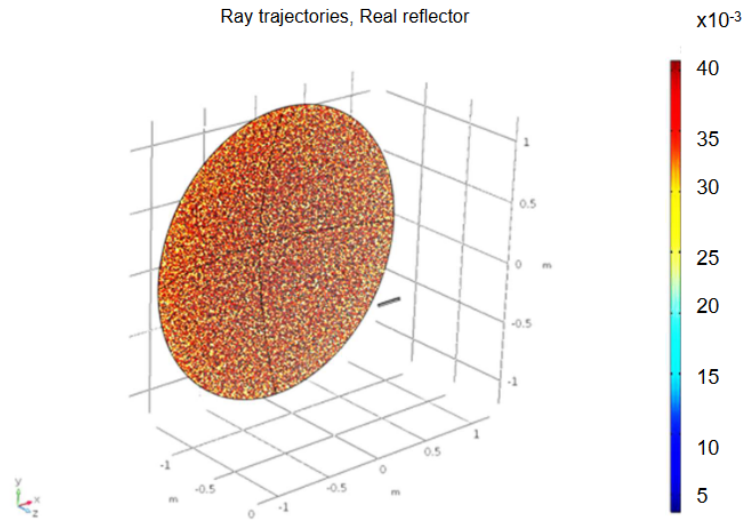
Figure 10. Since the surface of the disc was not perfectly smooth, the reflected rays were not all released in the exact theoretical direction but underwent completely random deviations.